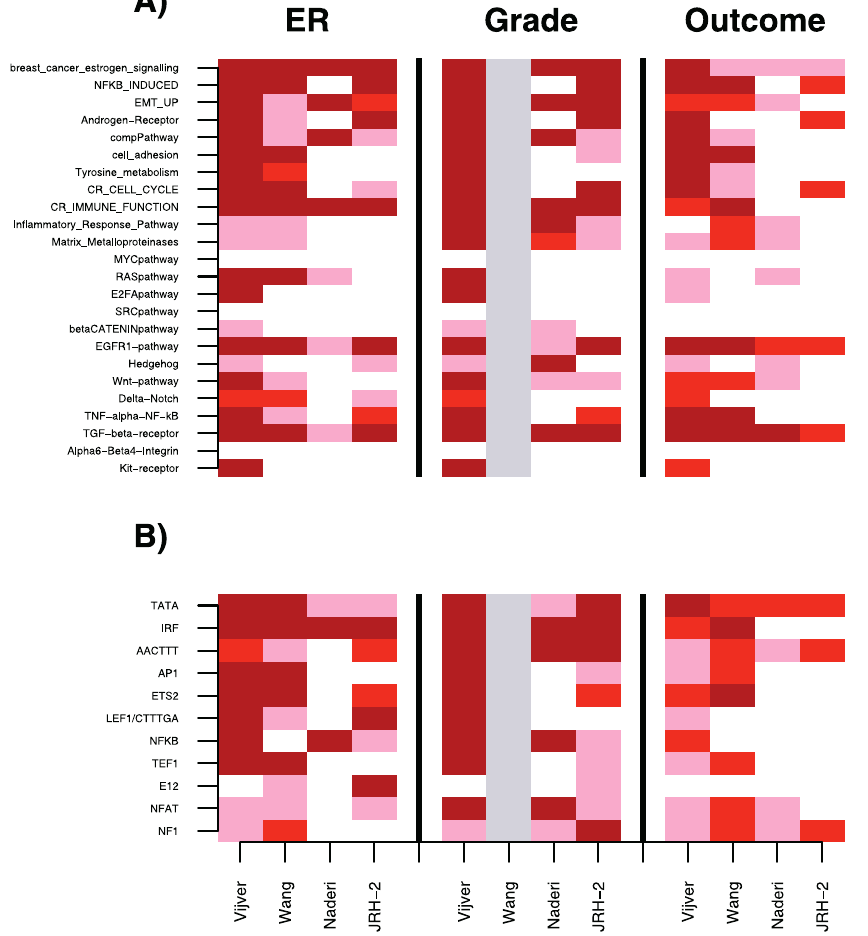
Figure 4. Heatmaps of Association of Pathways and Regulatory Modules with Breast Cancer Phenotypes For three phenotypes (ER, Grade, Outcome), we show heatmaps of association between phenotypes and selected pathways (A) and selected regulatory motifs (B), as revealed by the four ICA algorithms across the four major breast cancer cohorts. For phenotypes, we used a p -value threshold of 0.05 to establish whether an ICA component was associated with that phenotype. For pathways and regulatory modules, we used the Benjamini corrected p - values as before. For each cohort, we then counted the number of ICA algorithms that found a component linking a phenotype with a pathway/ regulatory module, which was colour-coded as 4 (dark red), 3 (red), 2 or 1 (pink), and 0 (white). For Wang’s cohort, grade information was unavailable and is colour-coded as